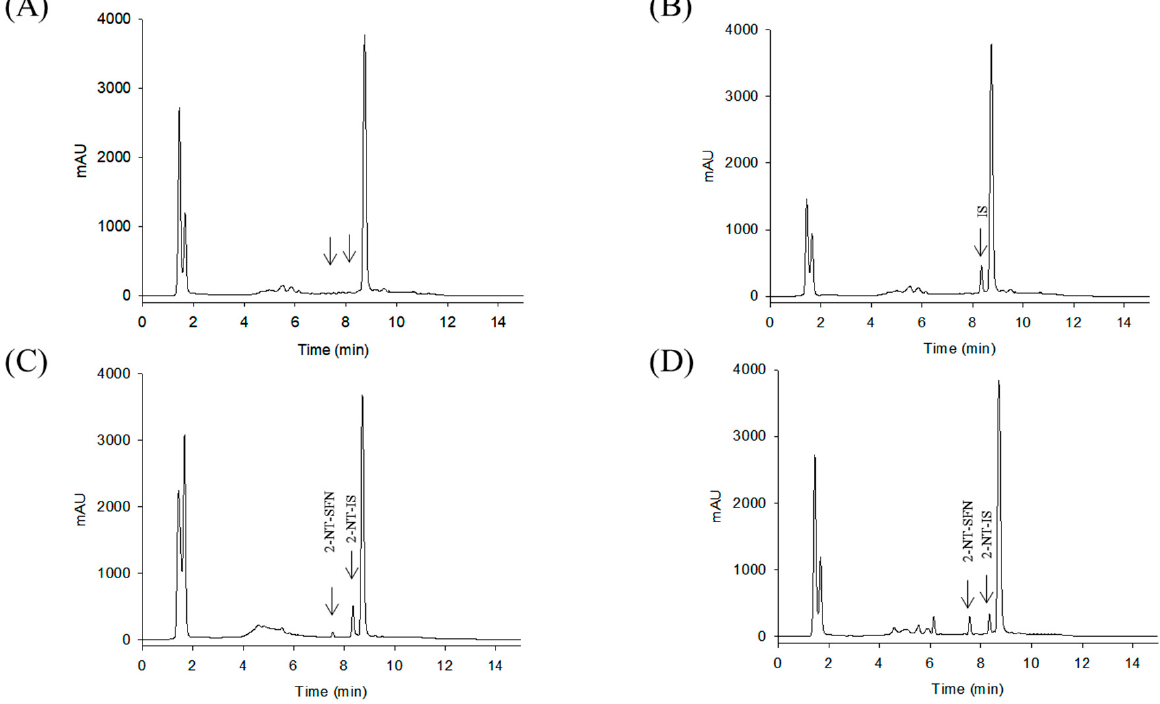
Figure 2. Representative HPLC chromatograms of double blank rat plasma ( A ), blank rat plasma spiked with the IS ( B ), blank rat plasma spiked with 0.01 μ g/mL of SFN (LLOQ) or the IS ( C ), a plasma sample obtained 1 h after a single oral administration of 10 mg/kg of SFN ( D ). SFN, sulforaphane; 2-NT, 2-naphthalenethiol.